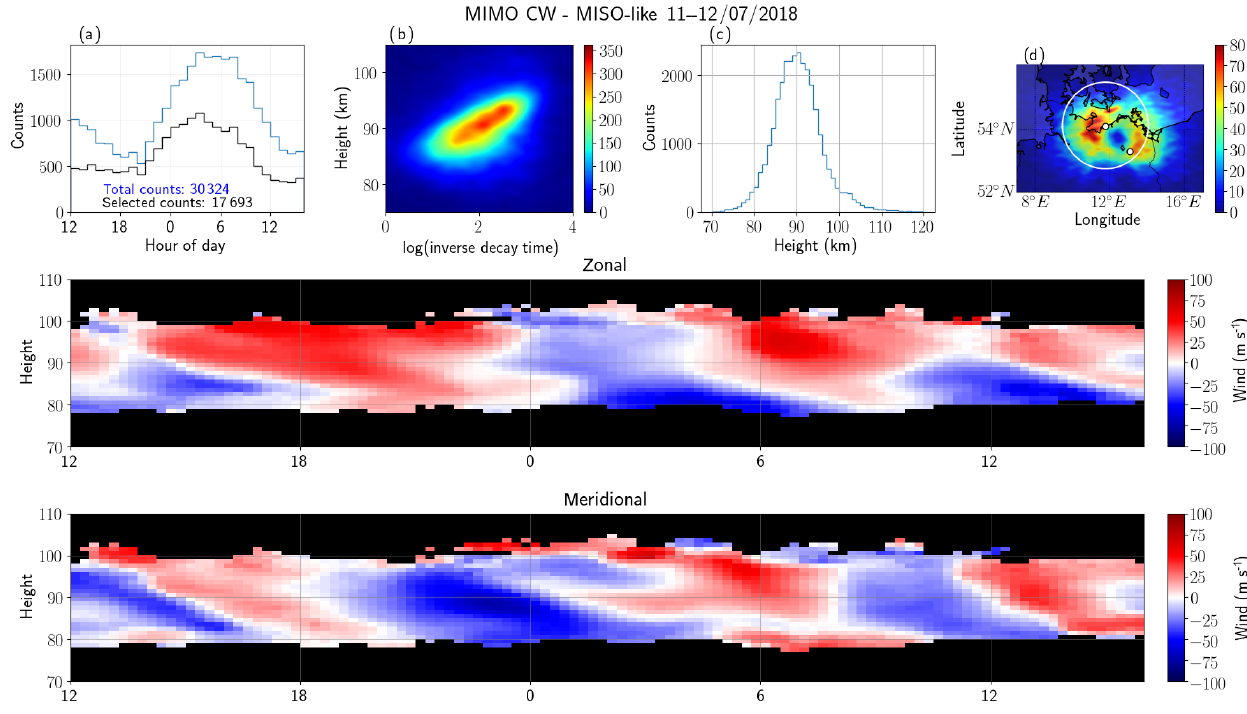
Figure 6. Similar to Fig. 4 but for the MIMO-CW system, applying a MISO-like analysis.